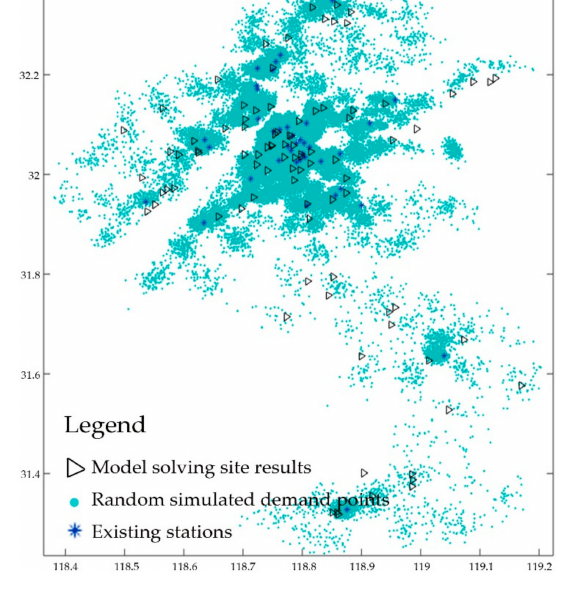
Figure 9. Site selection results.